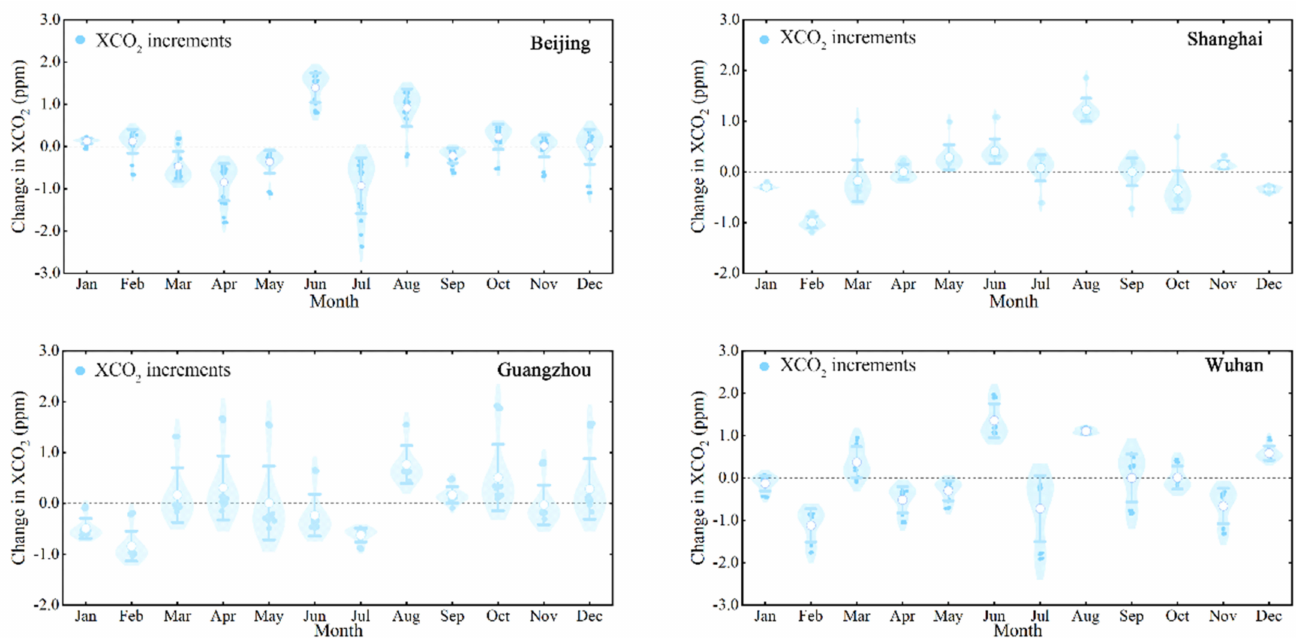
Figure 5. XCO 2 change in each month in 2020. The blue dot represents the XCO 2 increments in each grid (0.25 ◦ ) in the corresponding study area. Open points represent mean value, whereas the whiskers mark the standard deviation. The plotted violins represent the kernel density estimation of the probability density function for each